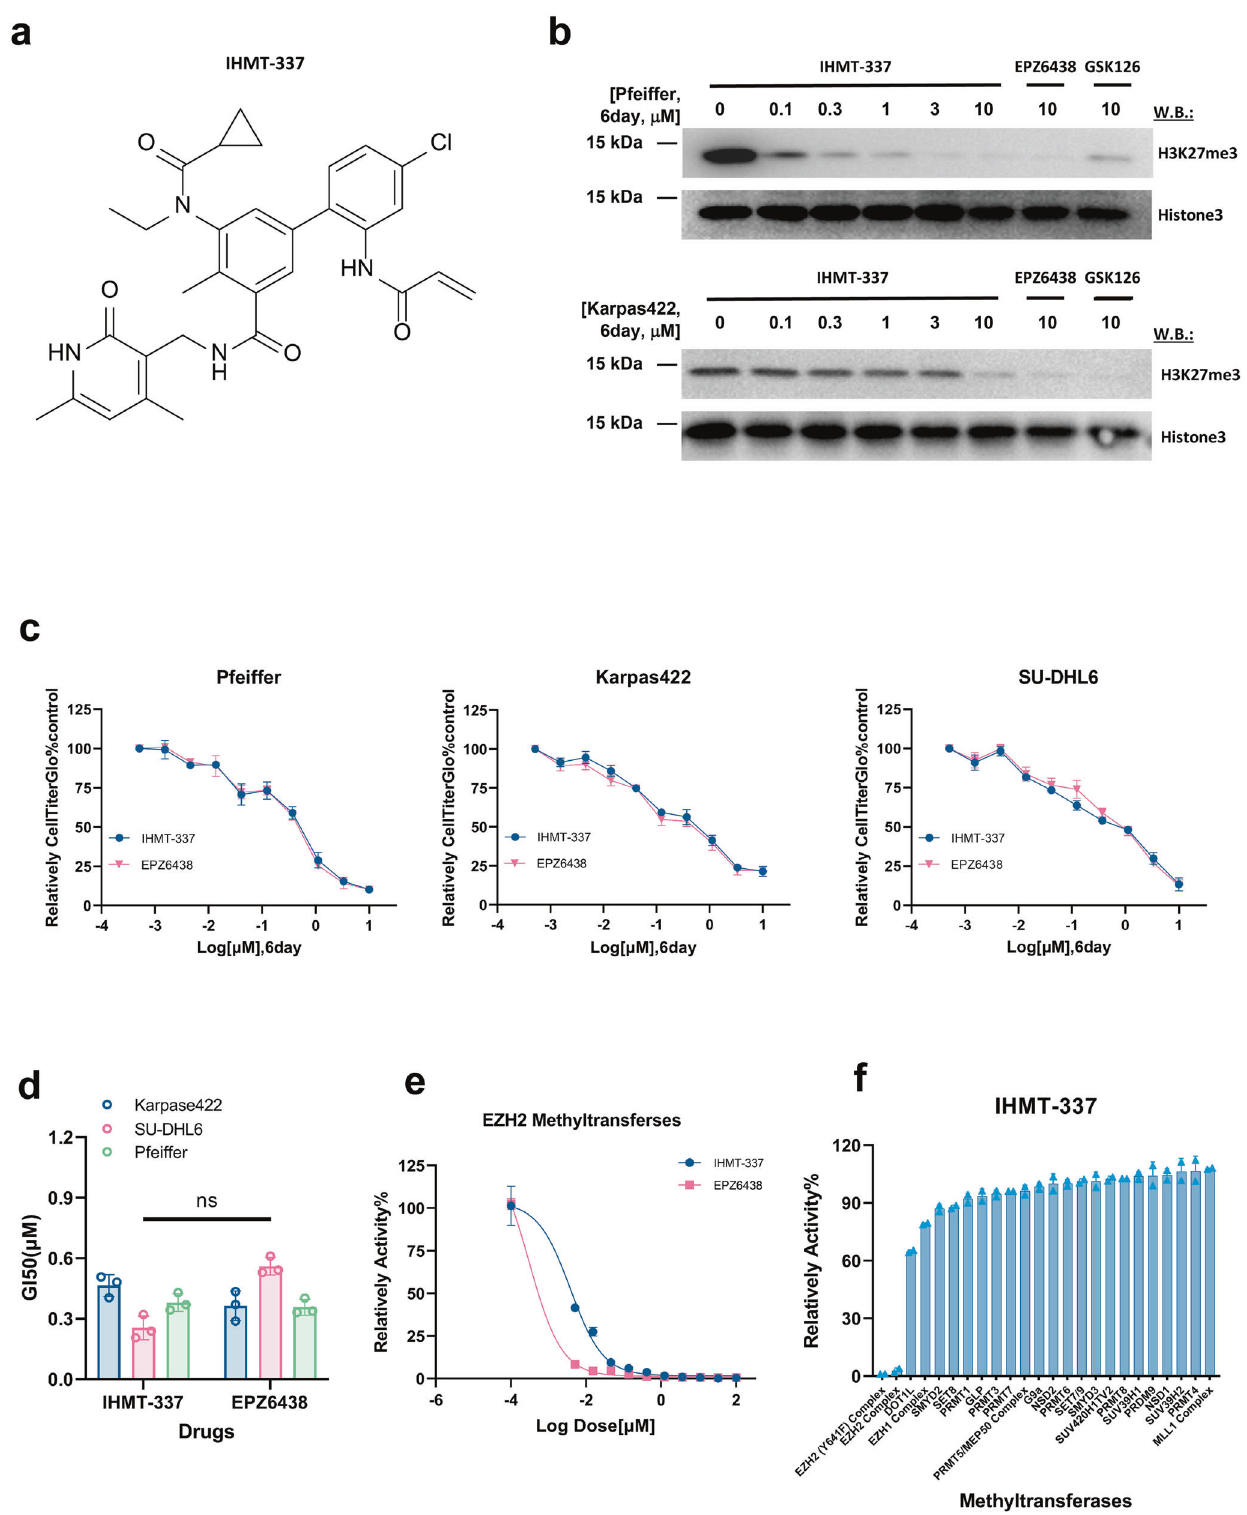
Fig. 1 Characterization of IHMT-337 as a highly selective EZH2 inhibitor. a Chemical structure of IHMT-337. b EZH2 signaling studies: Target effects of IHMT-337 on EZH2 signaling in Pfeiffer and Karpas422 cell lines. EPZ6438 (the FDA-approved EZH2 inhibitor) was set as control. c Proliferation studies: Effects of 6-day IHMT-337 treatment of Pfeiffer,Karpas422 and SU-DHL6 cell lines. EPZ6438 was set as control. d The GI50 values (the concentrations that cause 50% growth inhibition) of IHMT-337 and EZP6438 to DLBCL cell lines were shown. e Biochemical assays: the effects of IHMT-337 on EZH2 methyltransferase activity on PRC2/EZH2 complex. f Methyltransferase selectivity pro fi ling of IHMT- 337 generated from the Hotpot approach. Data shown were representative of at least 2 independent experiments